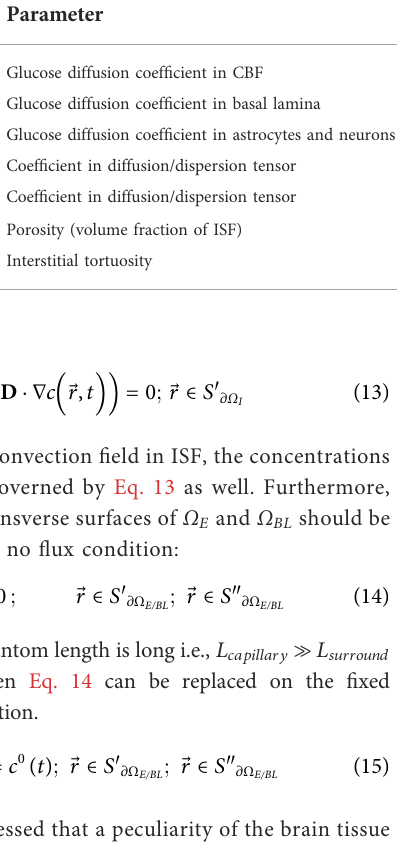
TABLE 3 The diffusion property of the medium. Diffusion coef fi cients for glucose considered as mean physical values which will be used as D c in Eq. 10 (Simpson et al., 2007). Symbol Parameter